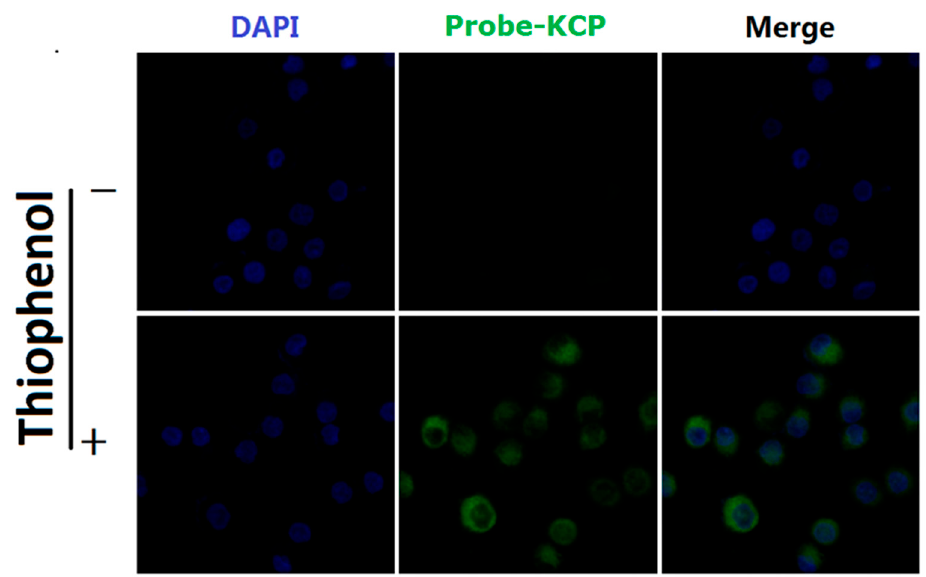
Figure 6. Imaging of 4 ‐ methoxythiophenol in living A549 cells using the probe ‐ KCP. The A549 cells were pretreated with 4 ‐ methoxythiophenol (300 μ M) for 30 min at 37 °C and then incubated with the probe ‐ KCP (10 μ M) for 30 min at 37 °C.